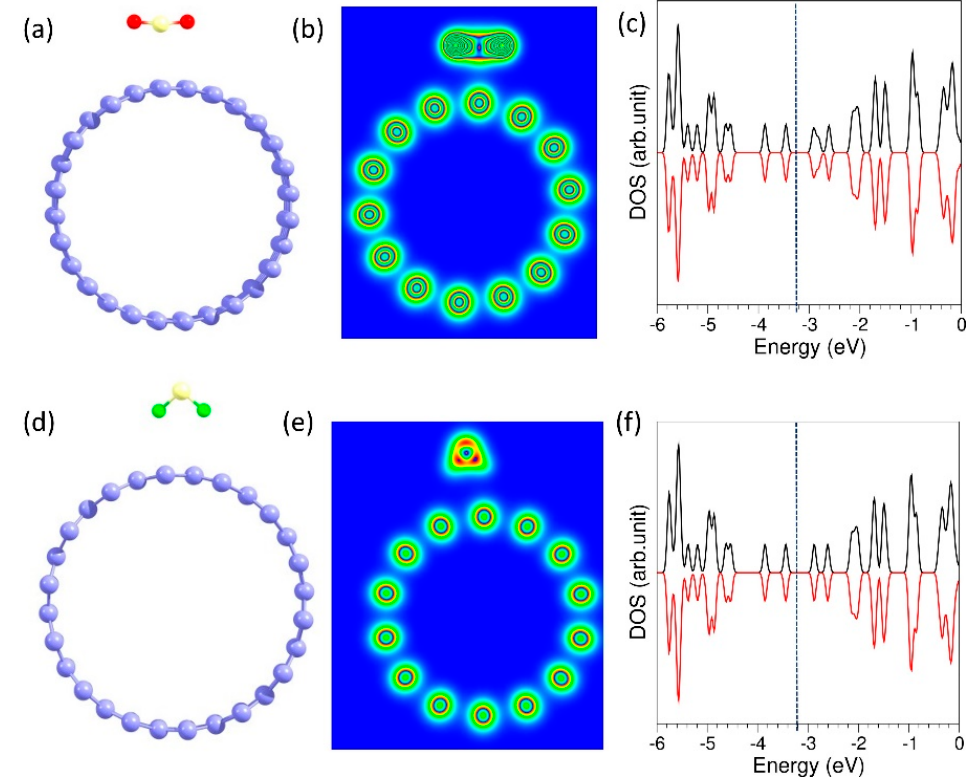
Figure 2. ( a ) Relaxed structure of a single SO 2 molecule adsorbed on the surface of SWNT, ( b ) charge density plot showing the interaction of SO 2 molecule with the nanotube, ( c ) DOS plot of SO 2 -adsorbed nanotube, ( d ) relaxed structure of H 2 S molecule adsorbed on the surface of the nanotube, ( e ) its charge density plot, and ( f ) DOS plot of H 2 S-adsorbed nanotube. Vertical dashed lines correspond to the Fermi level. Table 2. Calculated adsorption energies with respect to molecules, the amount of charge transferred between the nanotube and the molecule, and net magnetic moments of pristine nanotube and the adsorbed complexes.